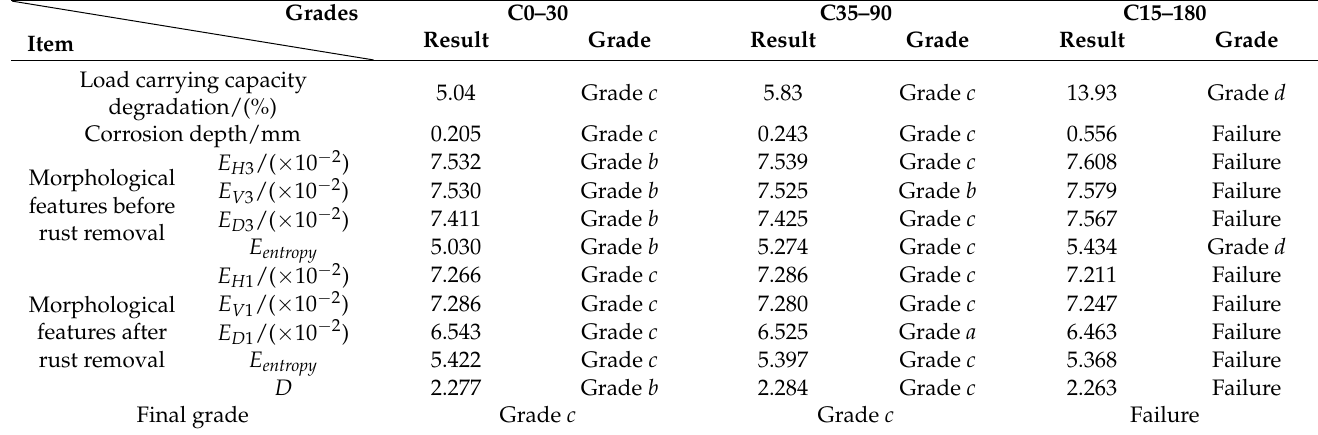
Figure 9. Morphology of each member before and after rust removal: ( a ) C0 – 30, ( b ) C35 – 90, ( c ) C15 – 180. Table 11. Comprehensive safety evaluation results of calculation examples.